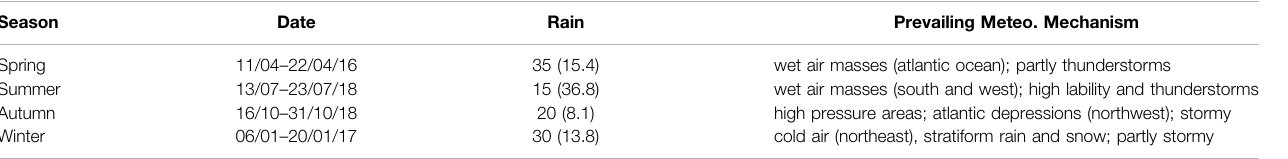
TABLE 2 | Overview of chosen episodes with date, rain mean [mm] (maximum intensity [mm/h]) and driving meteorological mechanisms. Rain values are derived from German precipitation stations. Season